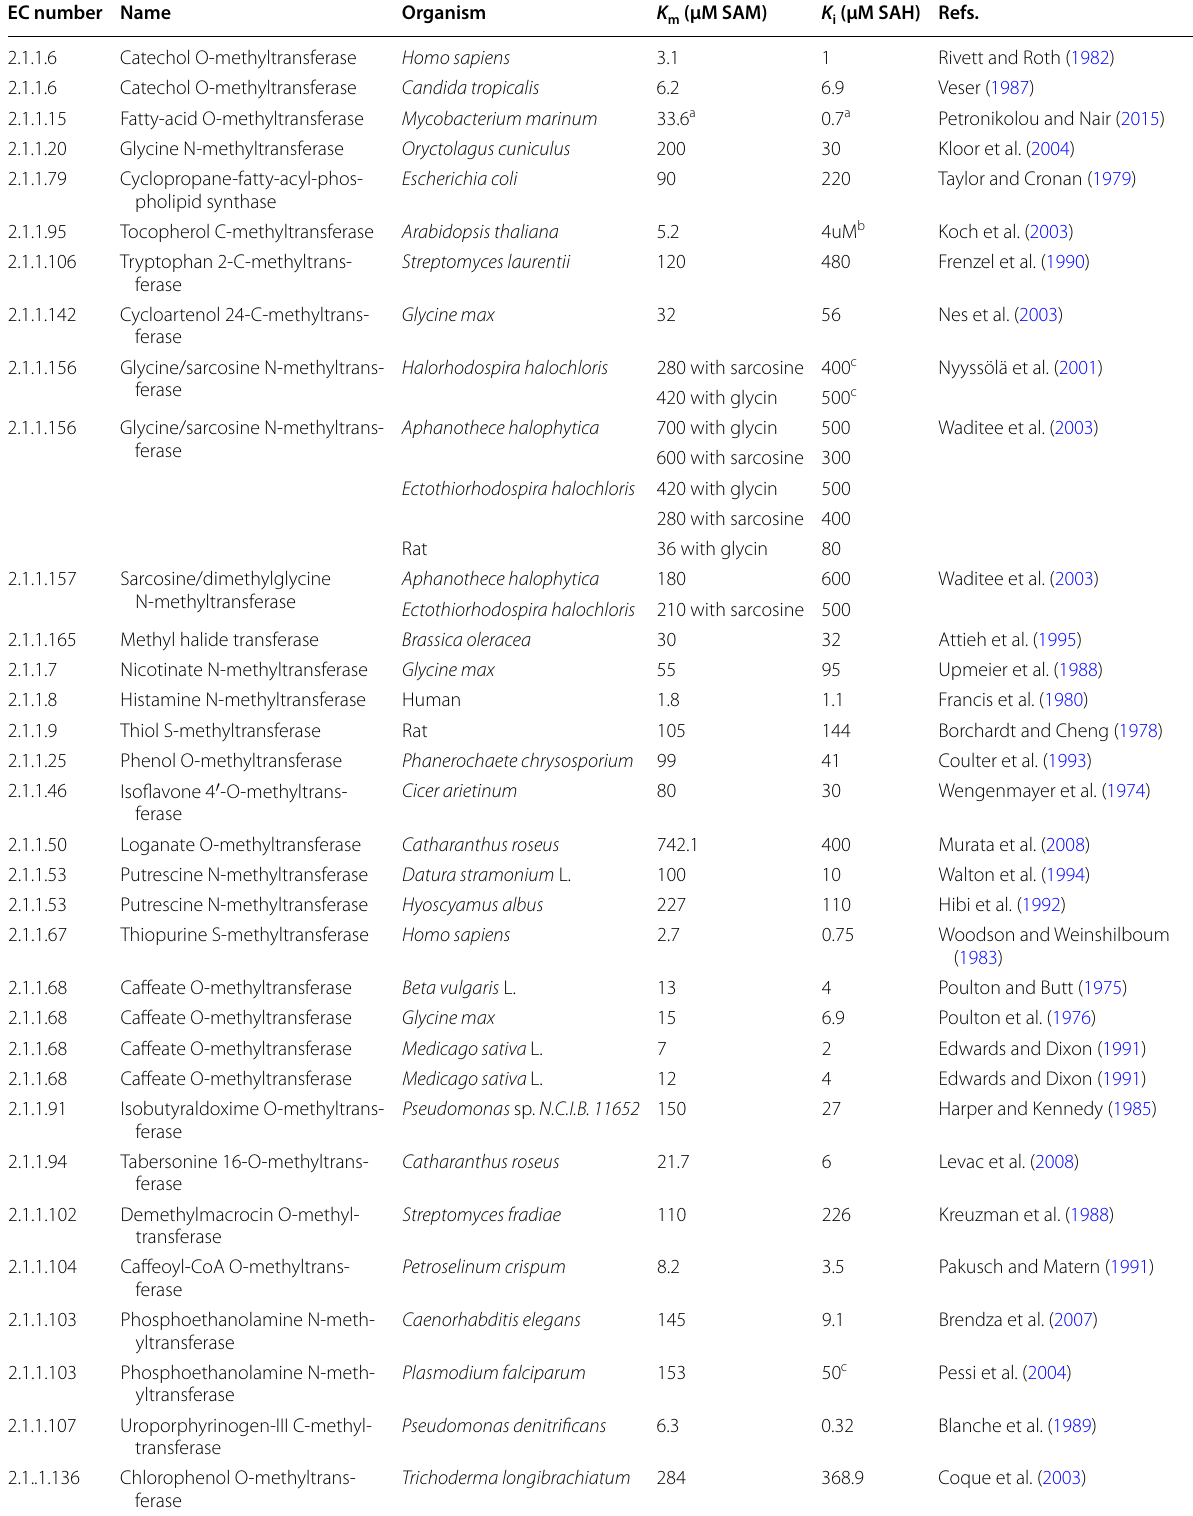
and K of all the small molecule methyltransferase in m,SAM i,SAH